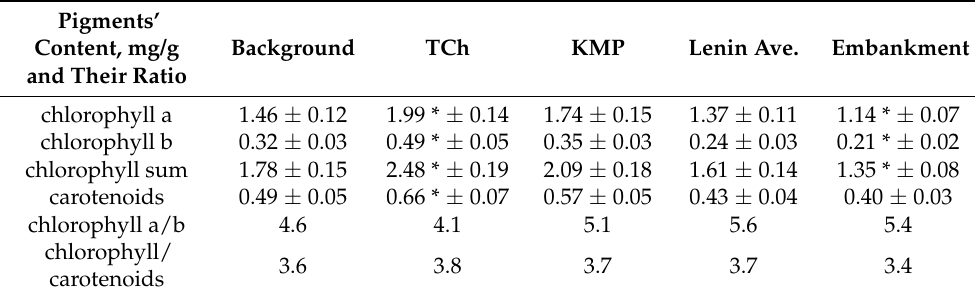
Table 3. Effect of the polyelemental pollution of soils on the quantitative characteristics of the photosynthetic pigments of Echinochloa frumentacea